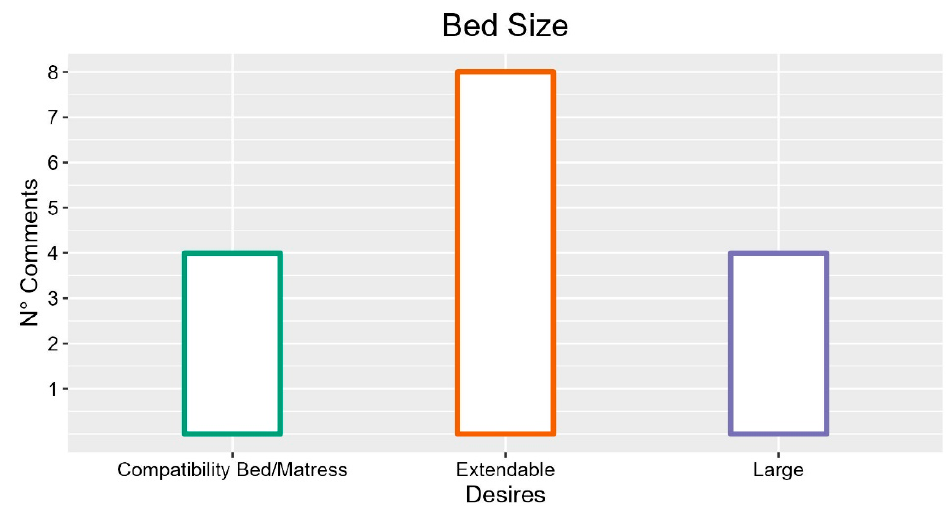
Figure 11. Graphical representation of desires with more occurrences for the Bed Size theme.